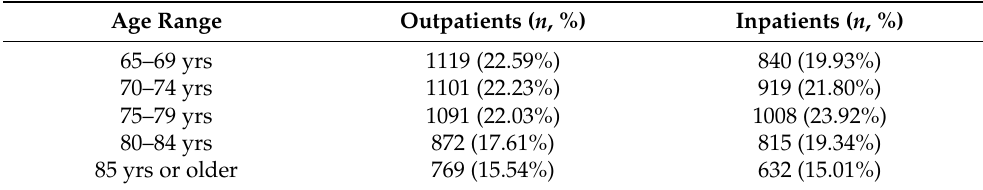
Table 1. Age distribution of the affected patients in the outpatient and inpatient groups (2008–2017).